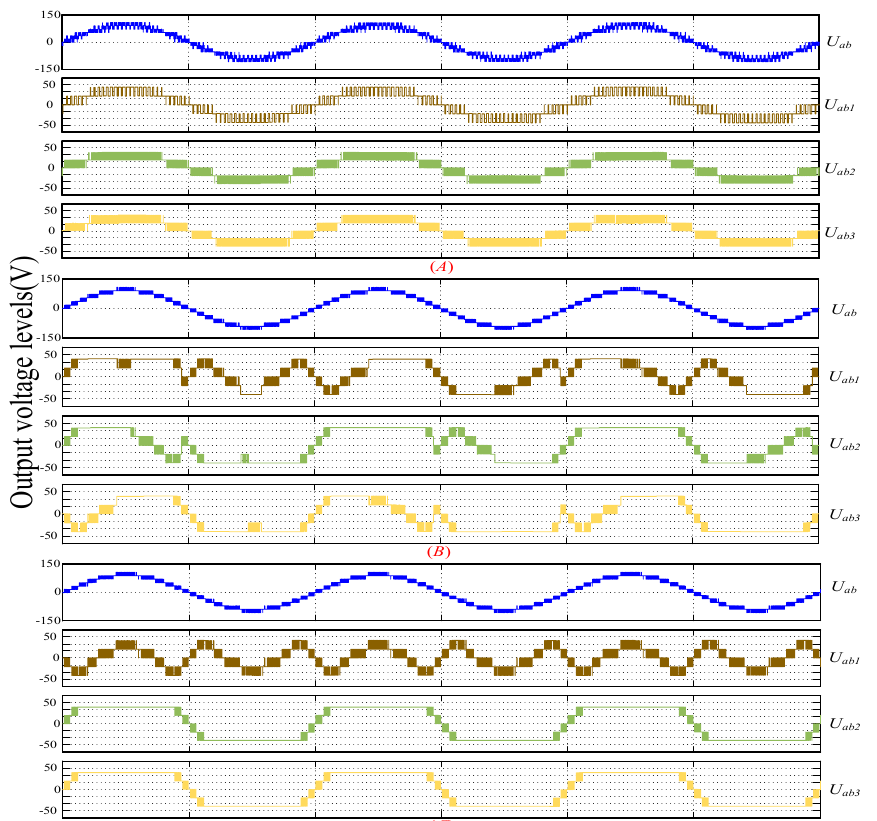
Figure 10. The output voltage levels waveforms of 3LNPC-CC.